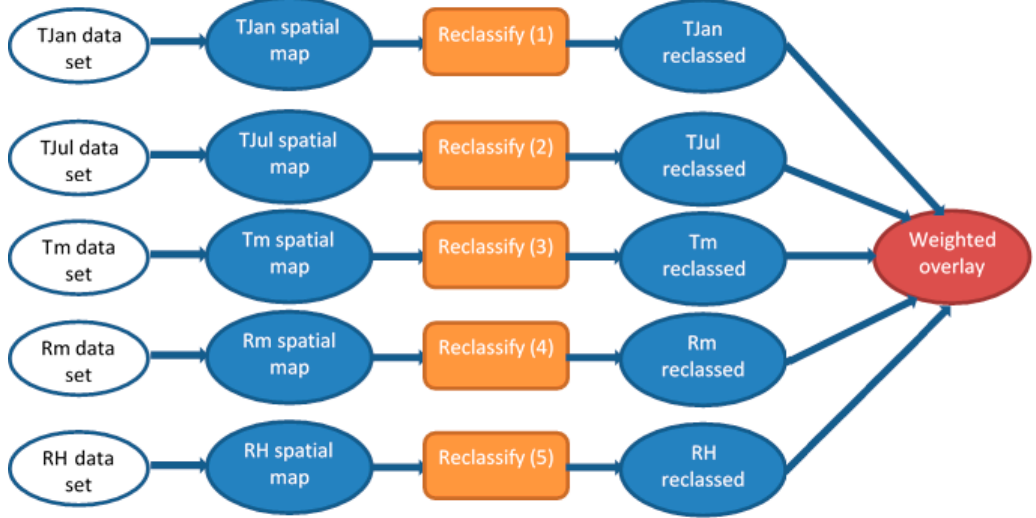
Figure 3. Scheme of a Geographic Information System (GIS) model.